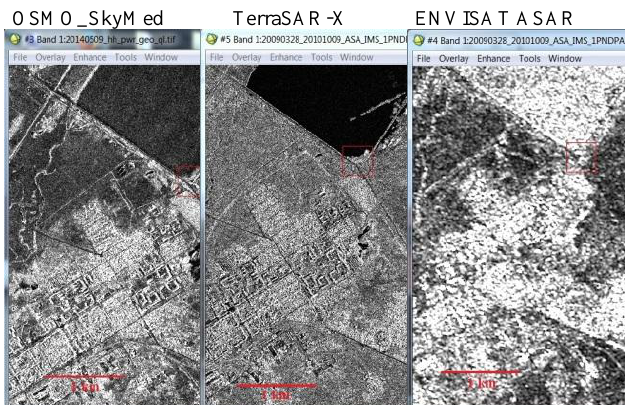
Figure 4. Selected satellite imagery quicklooks